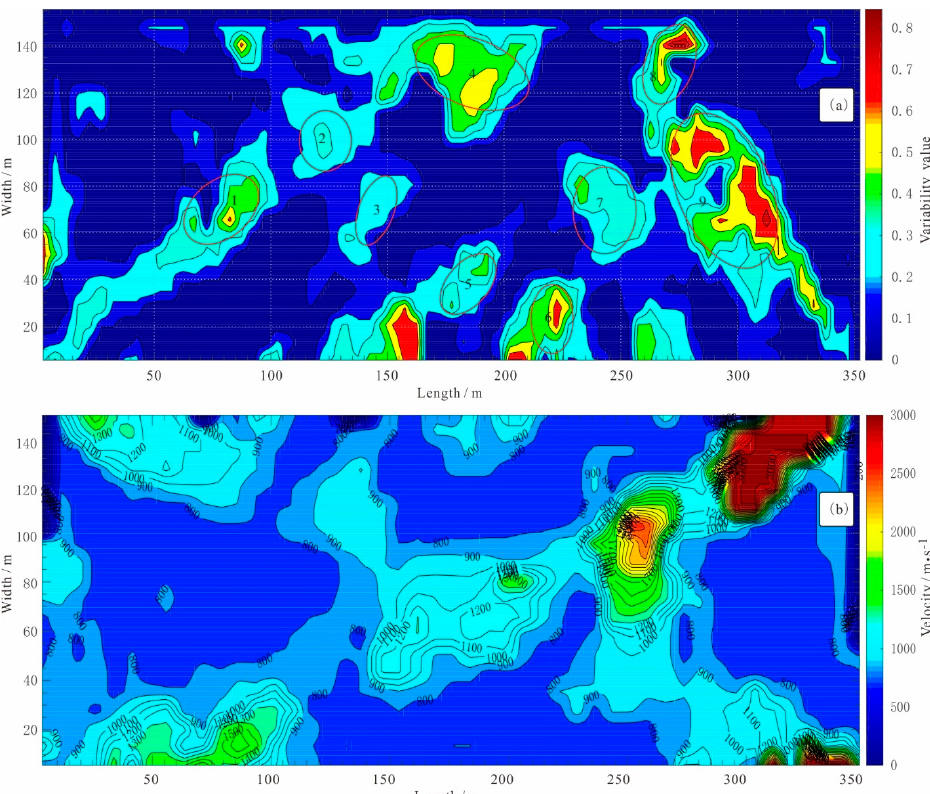
Figure 6. ( a ) Channel wave variability value distribution on Working Face 090606. Red circles indicate abnormal areas of collapse columns; ( b ) Travel time imaging results.